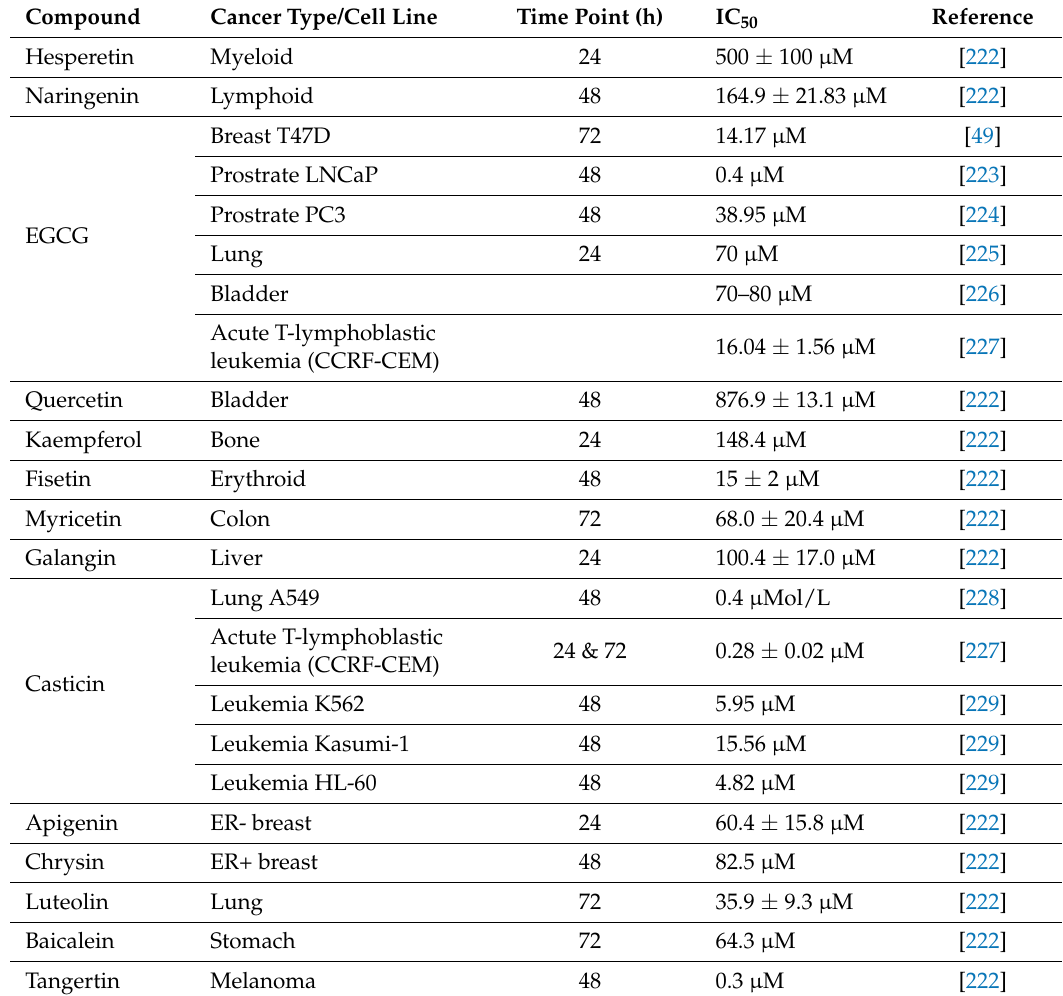
Table 1. IC 50 values of various flavonoids in different types of